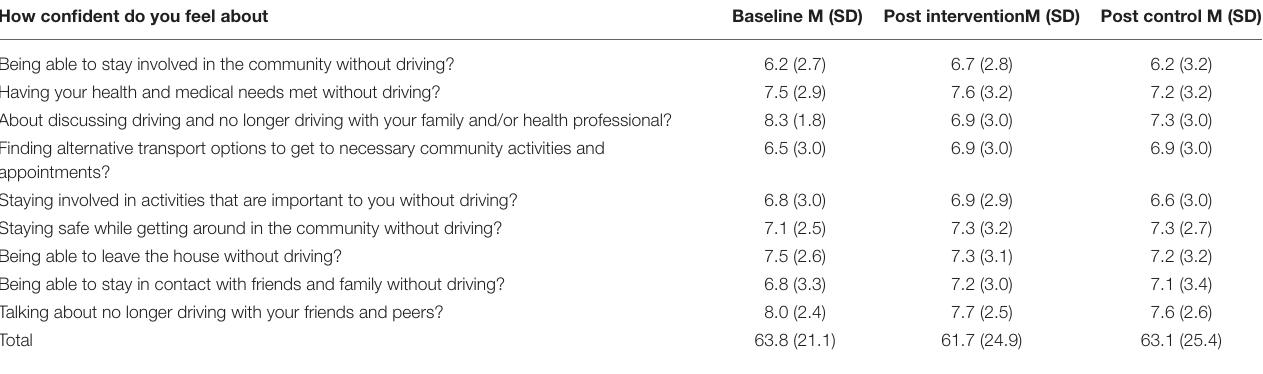
TABLE 6 | Community mobility self-efficacy scale. How confident do you feel